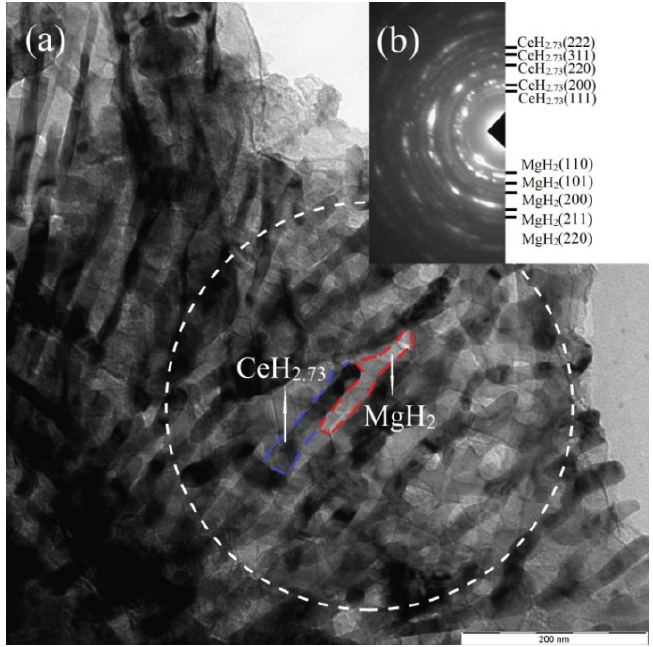
Figure 4. The bright field image of H-Mg 3 Ce composite structure ( a ) and selected area diffraction patterns ( b